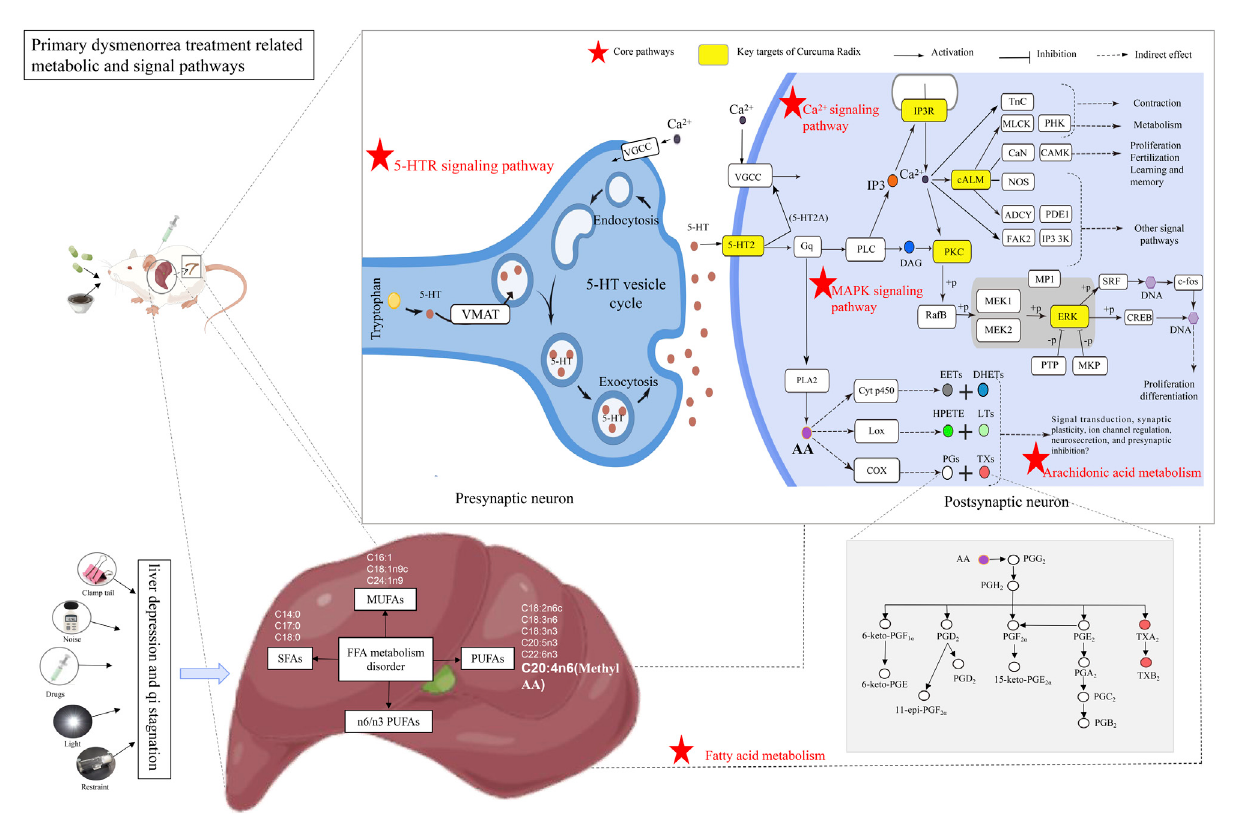
FIGURE 4 Therapeuticmechanism graphofCWacting onPD.Note:Theredpentagramrepresentsthecorepathway,theyellowboxrepresentsthekeytarget of turmeric action, the arrow indicates the activation effect, the T-shaped arrow indicates the inhibitory effect, and the dotted arrow represents the indirect